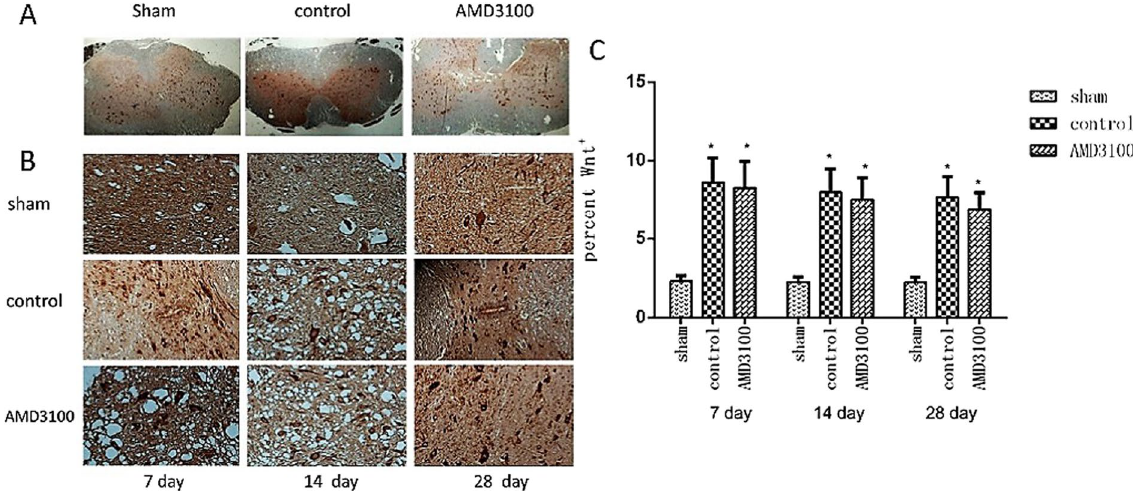
Figure 6. The expression of Wnt protein in the three groups of rats after surgery. ( A ) Representative images of IHC staining of Wnt in the three groups on the 7th day after surgery ( × 40). ( B ) Representative images of IHC staining of Wnt in the three groups ( × 400). It showed that the expression of Wnt protein in AMD3100 and untreated groups increased after surgery. ( C ) The expression level of Wnt protein was significantly higher in AMD3100 and untreated groups than those in sham group on the 7th, 14th and 28th day after surgery. However, no different was found for Wnt between AMD3100 and untreated groups at the different time. (